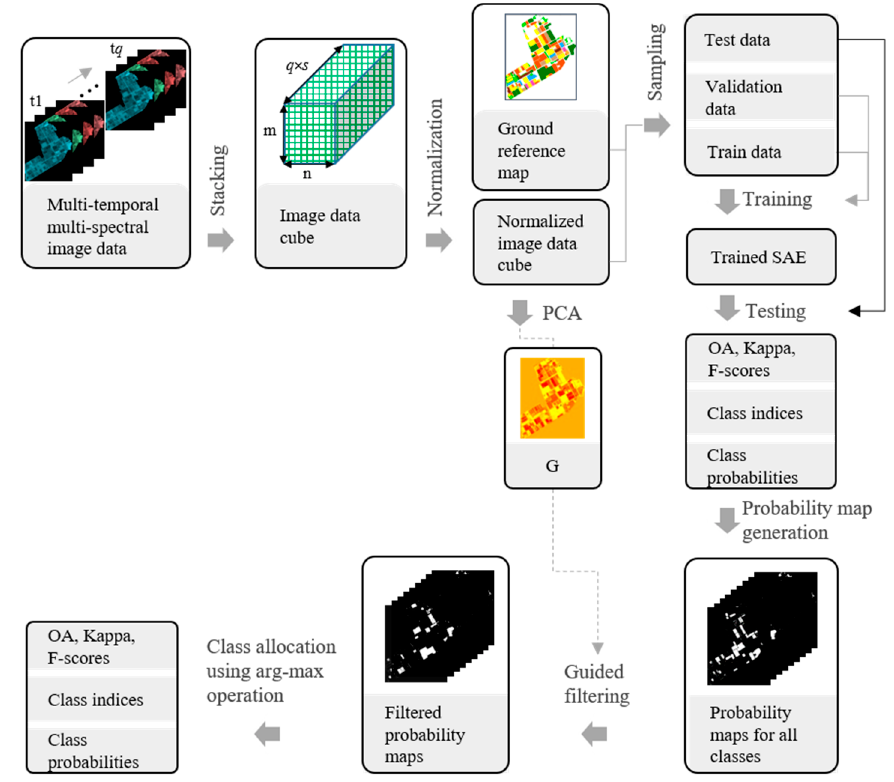
Figure 2. An overview of the proposed GFSAE classification framework.